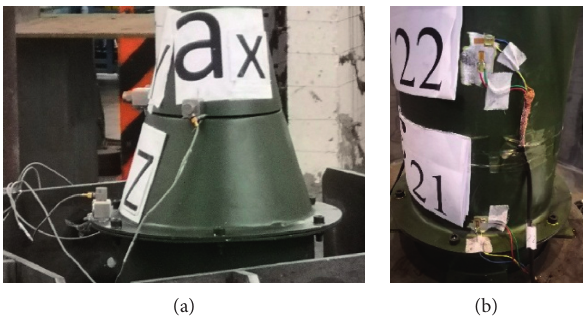
Figure 20: Layout of measuring sensors. (a) Measuring position of the acceleration sensor. (b) Measuring position of the strain gauge (a pair of strain gauges in a T-shaped